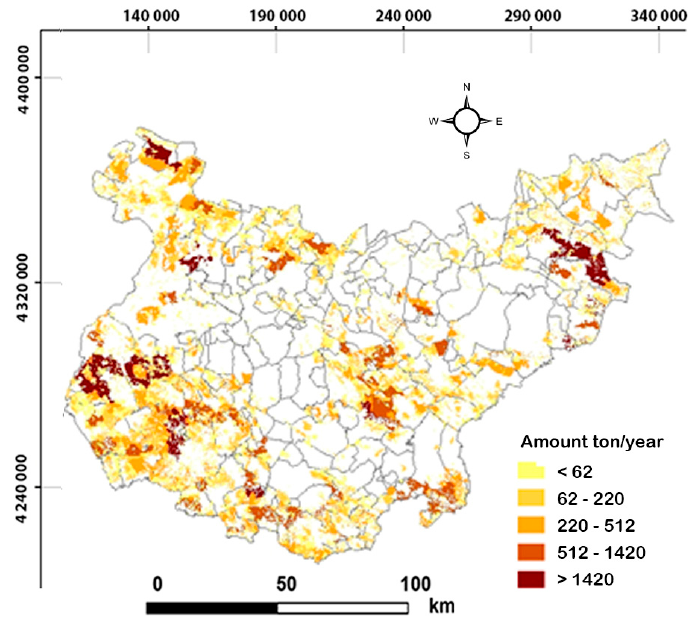
Figure 5. Geographic distribution of the forest biomass for energy use in the province of Badajoz.